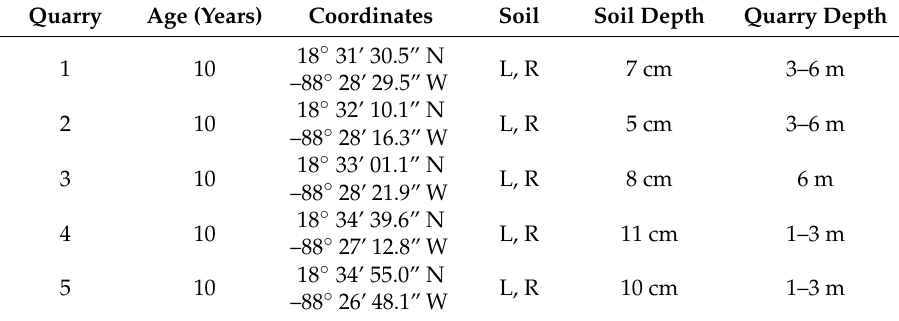
Table 1. The stand information of the five studied quarries. The approximate time of abandonment is presented in years. L = Leptosol; R =